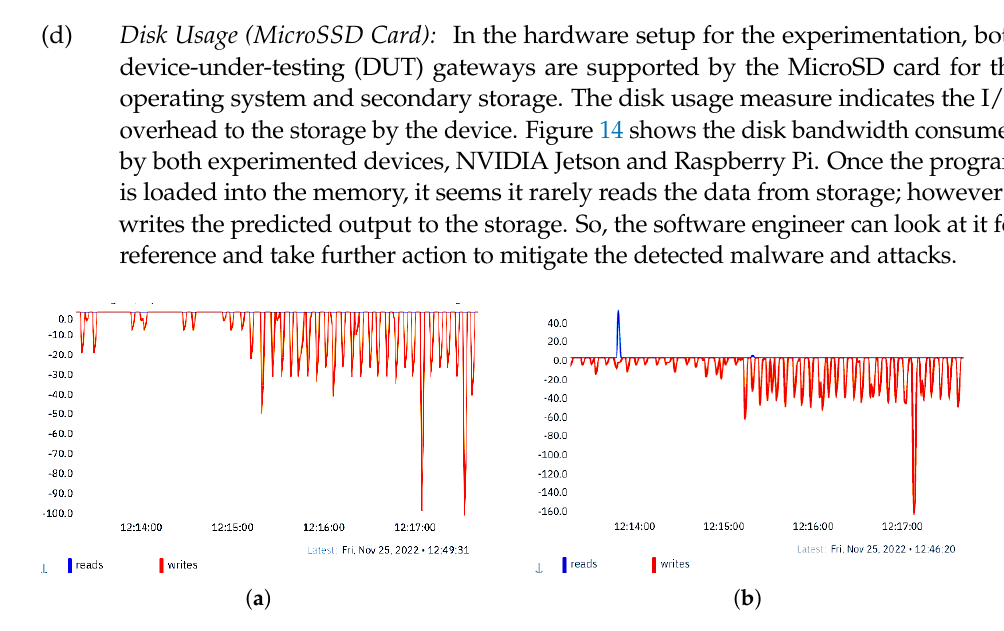
Figure 13. The variation in the RAM utilization on devices ( a ) Jetson, ( b ) Raspberry Pi (y → memory in GB and x → time).